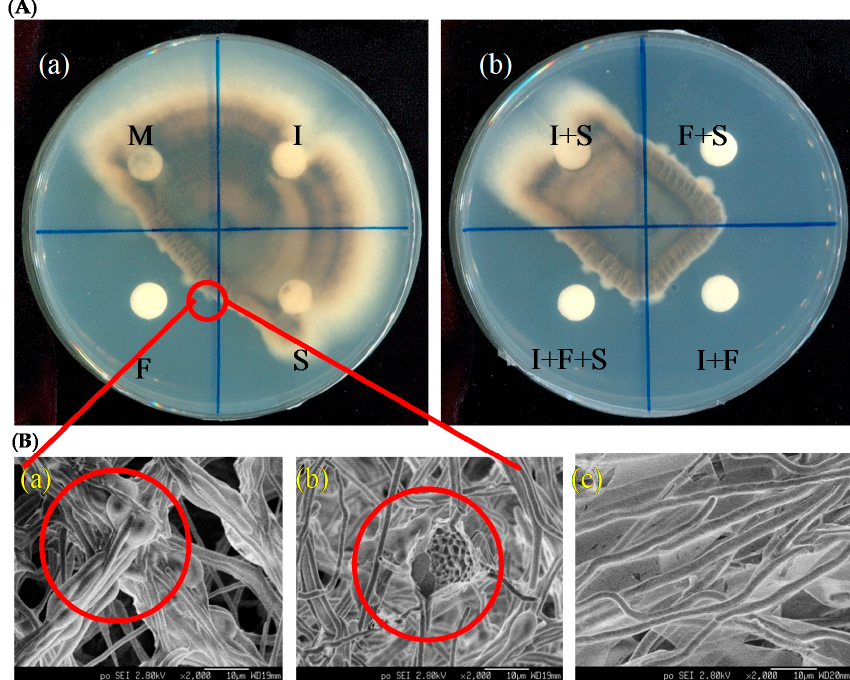
Figure 5. ( A ) Antifungal assay of commercial lipopeptide standards against P. oryzae , where I: iturins, F: fengycins, S: surfactins, and M: methanol; ( B ) The morphology for P. oryzae hyphae collected at the inhibition border via SEM observation. The fengycins-treated P. oryzae hyphae were ( a ) swollen or ( b ) cracked, where ( c ) was the untreated hyphae.